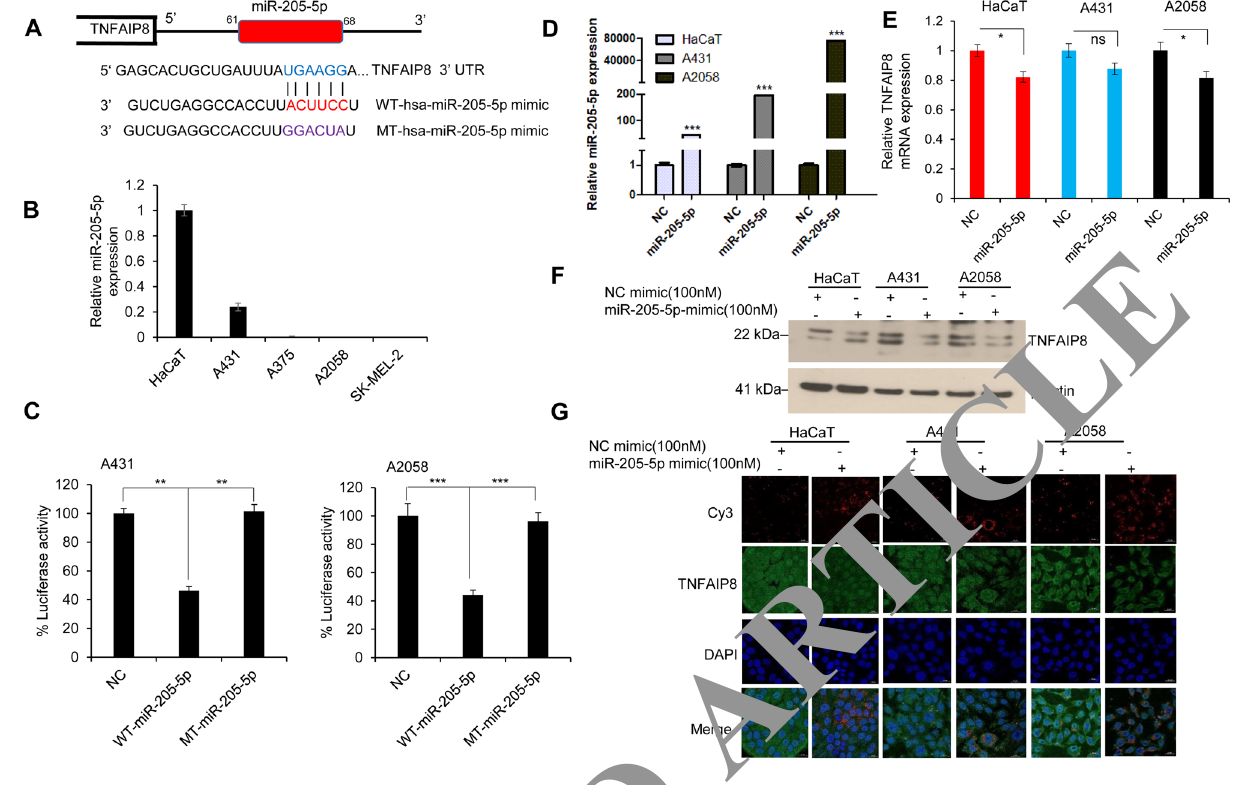
Figure 4. miR-205-5p targets the 3 ′ UTR of TNFAIP8 and inhibits TNFAIP8 expression. ( A ) The binding site of miR-205-5p in the 3 ′ UTR of TNFAIP8 was analyzed by TargetScan (http:// www. targe tscan. org/ vert_ 72/) and presented. We also generated a wild type and mutated binding nucleotides of miR-205-5p to the 3 ′ UTR of TNFAIP8. Wild-type miR-205-5p and mutant miR-205-5p mimics are shown. ( B ) Relative expression of miR-205-5p in HaCaT, A431, A375, A2058, and SK-MEL-2 cell lines was analyzed by RT/qPCR as described in the “Materials and methods” section. ( C ) Luciferase reporter assay: A431 and A2058 cells were transfected with TNFAIP8-3 ′ UTR-Luciferase reporter construct (0.5 µg) for 18 h and then transfected with NC mimic or wild-type miR-205-5p mimic or mutant miR-205-5p mimic for an additional 24 h. Transfected cells were lysed, and luciferase activity was measured. Results are representative of two independent experiments. ** P < 0.01, *** P < 0.001 compared with NC or mutant-type miR-205-5p mimic. ( D , E ) Normal or skin cancer cells were transfected with NC or miR-205-5p mimic for 48 h and the overexpression of miR-205-5p mimic and TNFAIP8 transcripts were analyzed by RT/qPCR. *** P < 0.001 compared with NC-transfected cells. * P < 0.05 compared with NC-transfected cells. ns-no significance. ( F ) HaCaT, A431 and A2058 cell lines were transfected with NC mimic or miR-205-5p mimic for 40 h and expression of endogenous TNFAIP8 protein were analyzed by western blotting. Western blots were developed using ECL chemiluminescence detection reagents, the blots were exposed to X-Ray films, scans were converted into grayscale and presented. ( G ) HaCaT, 431 and A2058 cell lines were grown on a coverslip and transfected with Cy3-labeled NC mimic or Cy3-labeled miR-205-5p mimic and the effect of Cy3-labeled miR-205-5p mimic on endogenous TNFAIP8 expression (green) was visualized by immunofluorescence as described in the “Materials and methods”